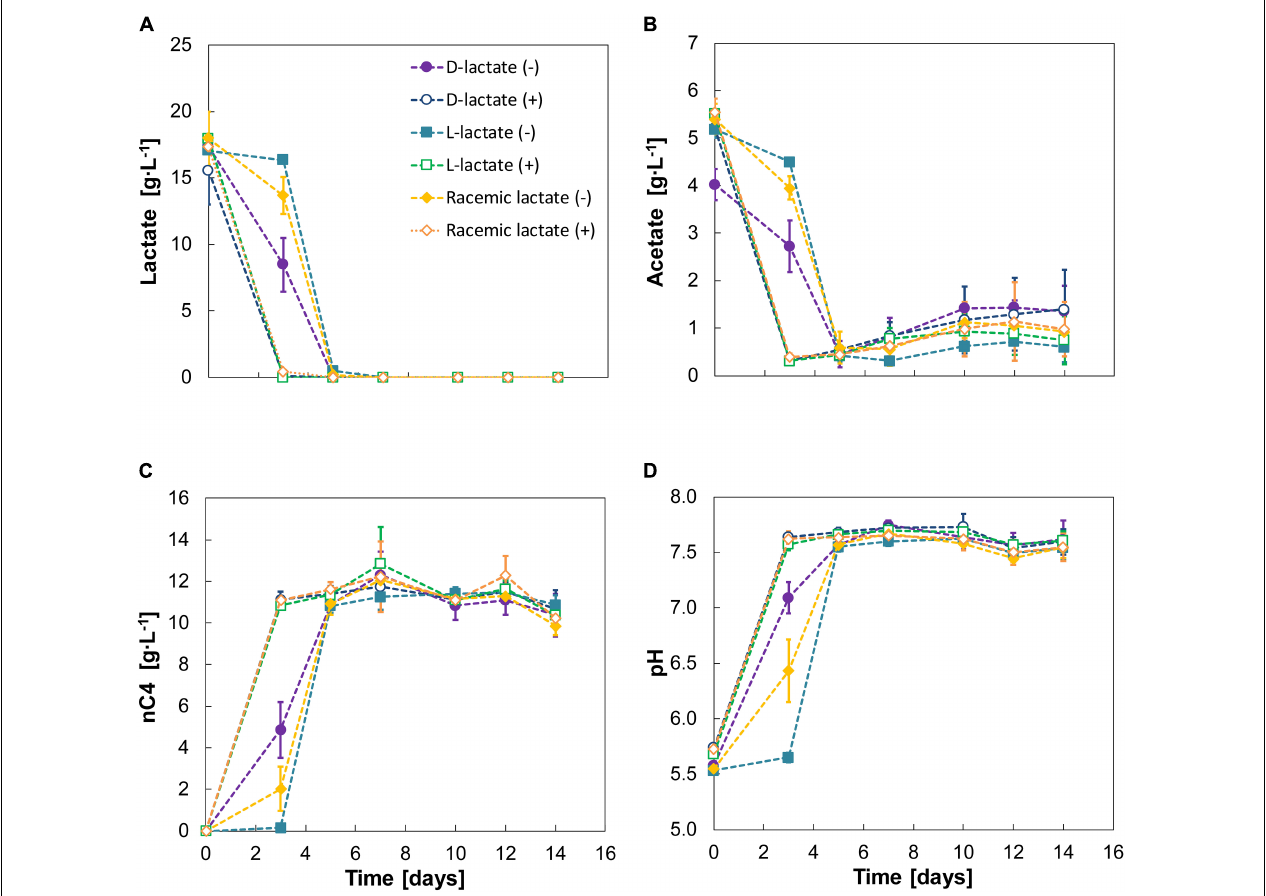
FIGURE 4 | Experiment IV—Substrate (A,B) , n-butyrate (C) and pH (D) profiles for D-lactate, L-lactate and racemic lactate conversion. A positive or negative sign between braces indicate absence (–) or presence (+) of nZVI (added at 1 g · L − 1 ). Error bars indicate ± one standard